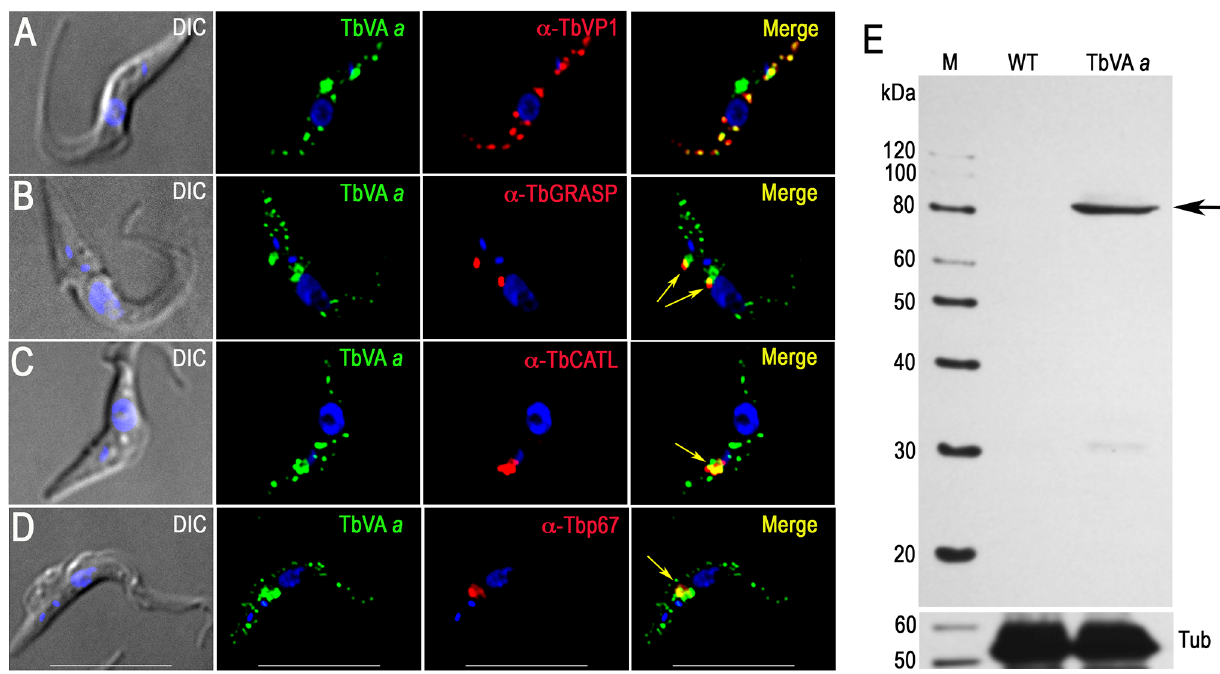
Fig. 4. Immunofluorescence microscopy and western blot analysis of V-H + -ATPase subunit a in PCF trypanosomes. Epitope-tagged V- H + -ATPase subunit a co-localizes with TbVP1 to the acidocalcisomes (A), with TbGRASP to the Golgi complex (B) with TbCATL (C) and with p67 (D) and to lysosomes (Pearson’s correlation coefficients of 0.631, 0.539, 0.804, and 0.754, respectively). Yellow in merge images indicate co-localization (also shown with arrows in (B–D)). Scale bars for (A–D)=10 m m. (E) Confirmation of tagging by western blot analyses with monoclonal anti-HA in PCF trypanosomes. HRP-conjugated goat anti-mouse was used as a secondary antibody. Magic Mark XP (Invitrogen) was used as a molecular weight marker and arrow shows band corresponding to TbVA a . Tubulin (Tub) was used as a loading control ( bottom panel